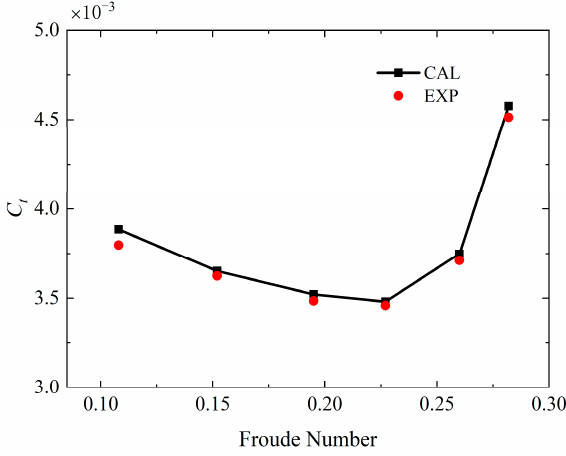
Figure 10. Comparison of total resistance coefficients of KCS.